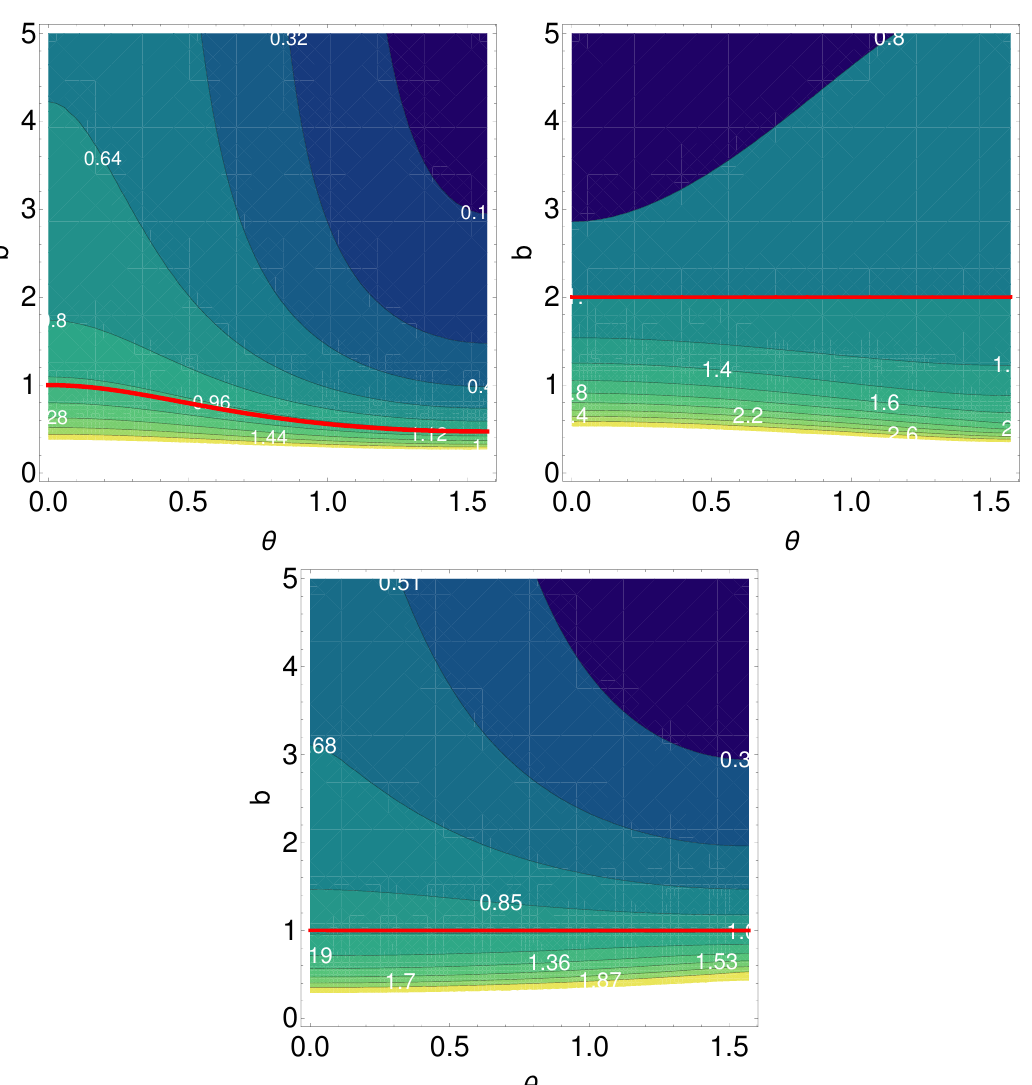
Figure 5 . (Color online) Contour plot showing various causal regions, obtained from eq. (4.54), for Alfv(cid:19)en mode (top left) and the set of fast (top right) and slow modes (bottom) from eq. (4.54). The red contour is the critical line of causality, denoting v 2 = 1. The region above the red line is L causal and below it corresponds to the acausal zone. The magnitude of the magnetic (cid:12)eld has been (cid:12)xed to qB = 10 m 2 and the other parameters used are (cid:11) = 1 = 3, T = 200 MeV. (cid:25)